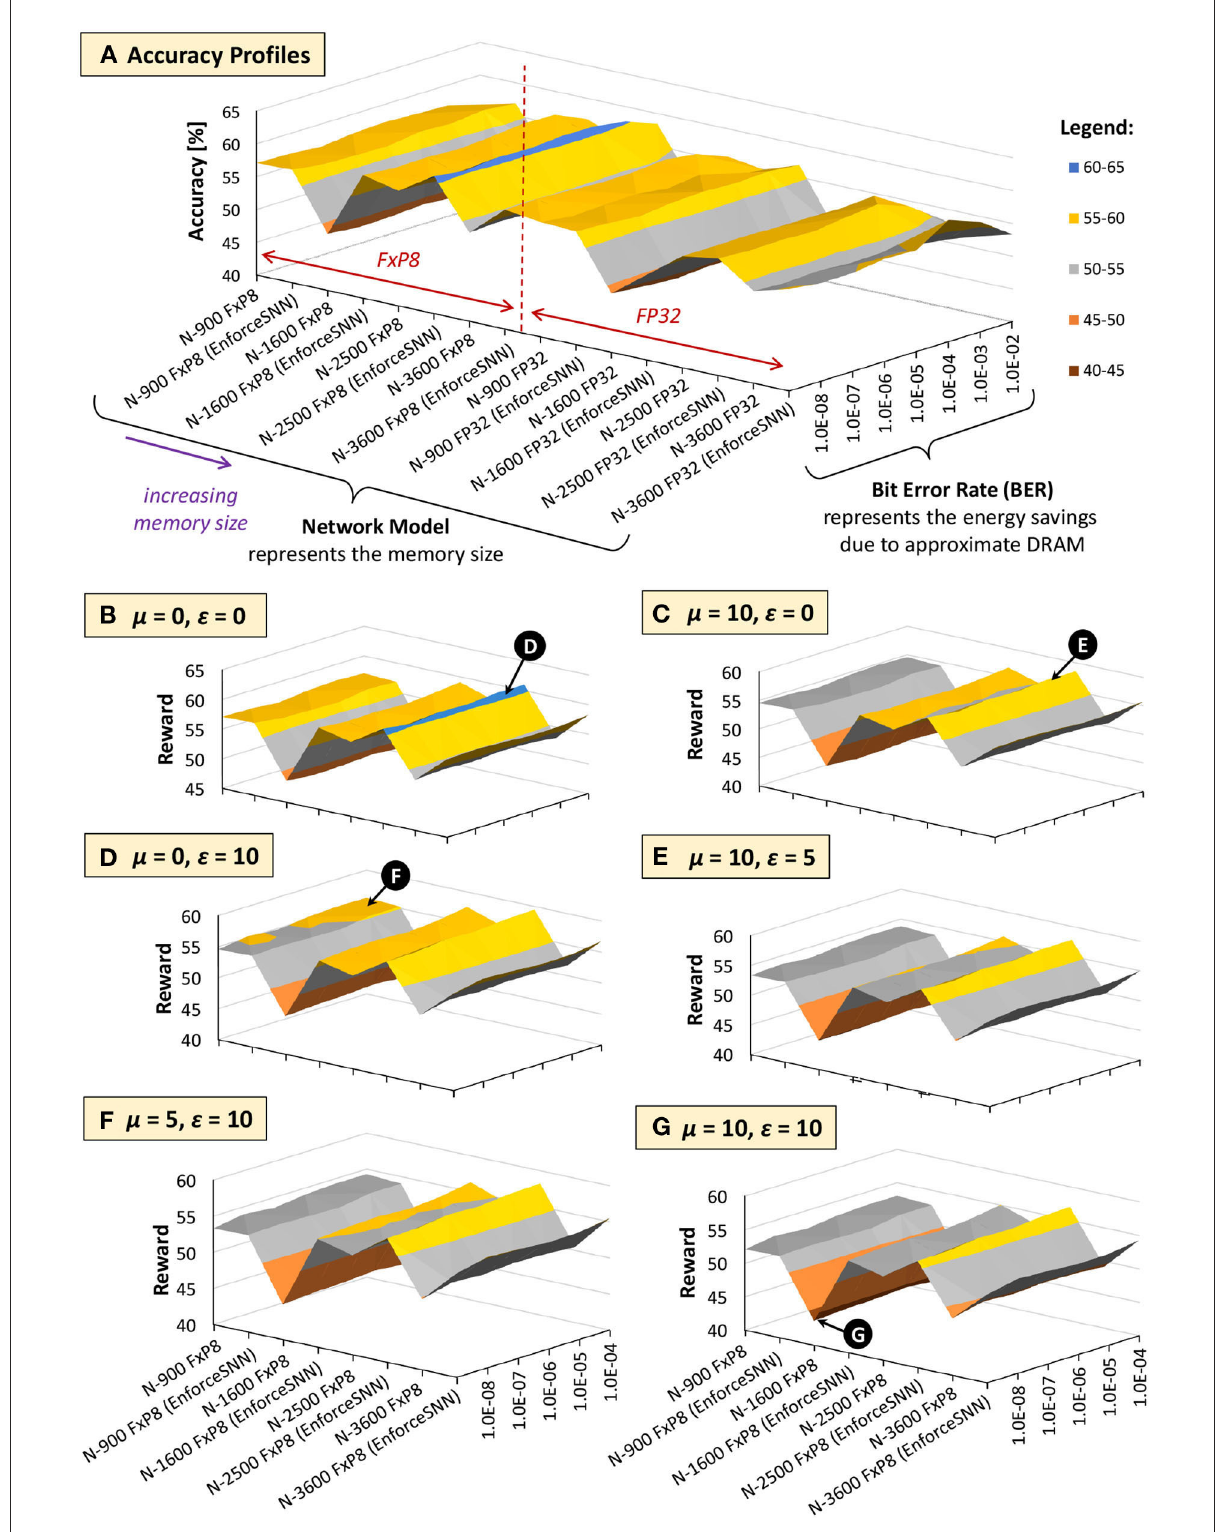
FIGURE14 The trade-offs among accuracy, memory, and energy consumption for the Fashion MNIST. (A) Accuracy profiles of SNN models. (B–G) Reward profiles of SNN models. The network sizes represent the memory sizes, and the BER values represent the energy savings from approximate